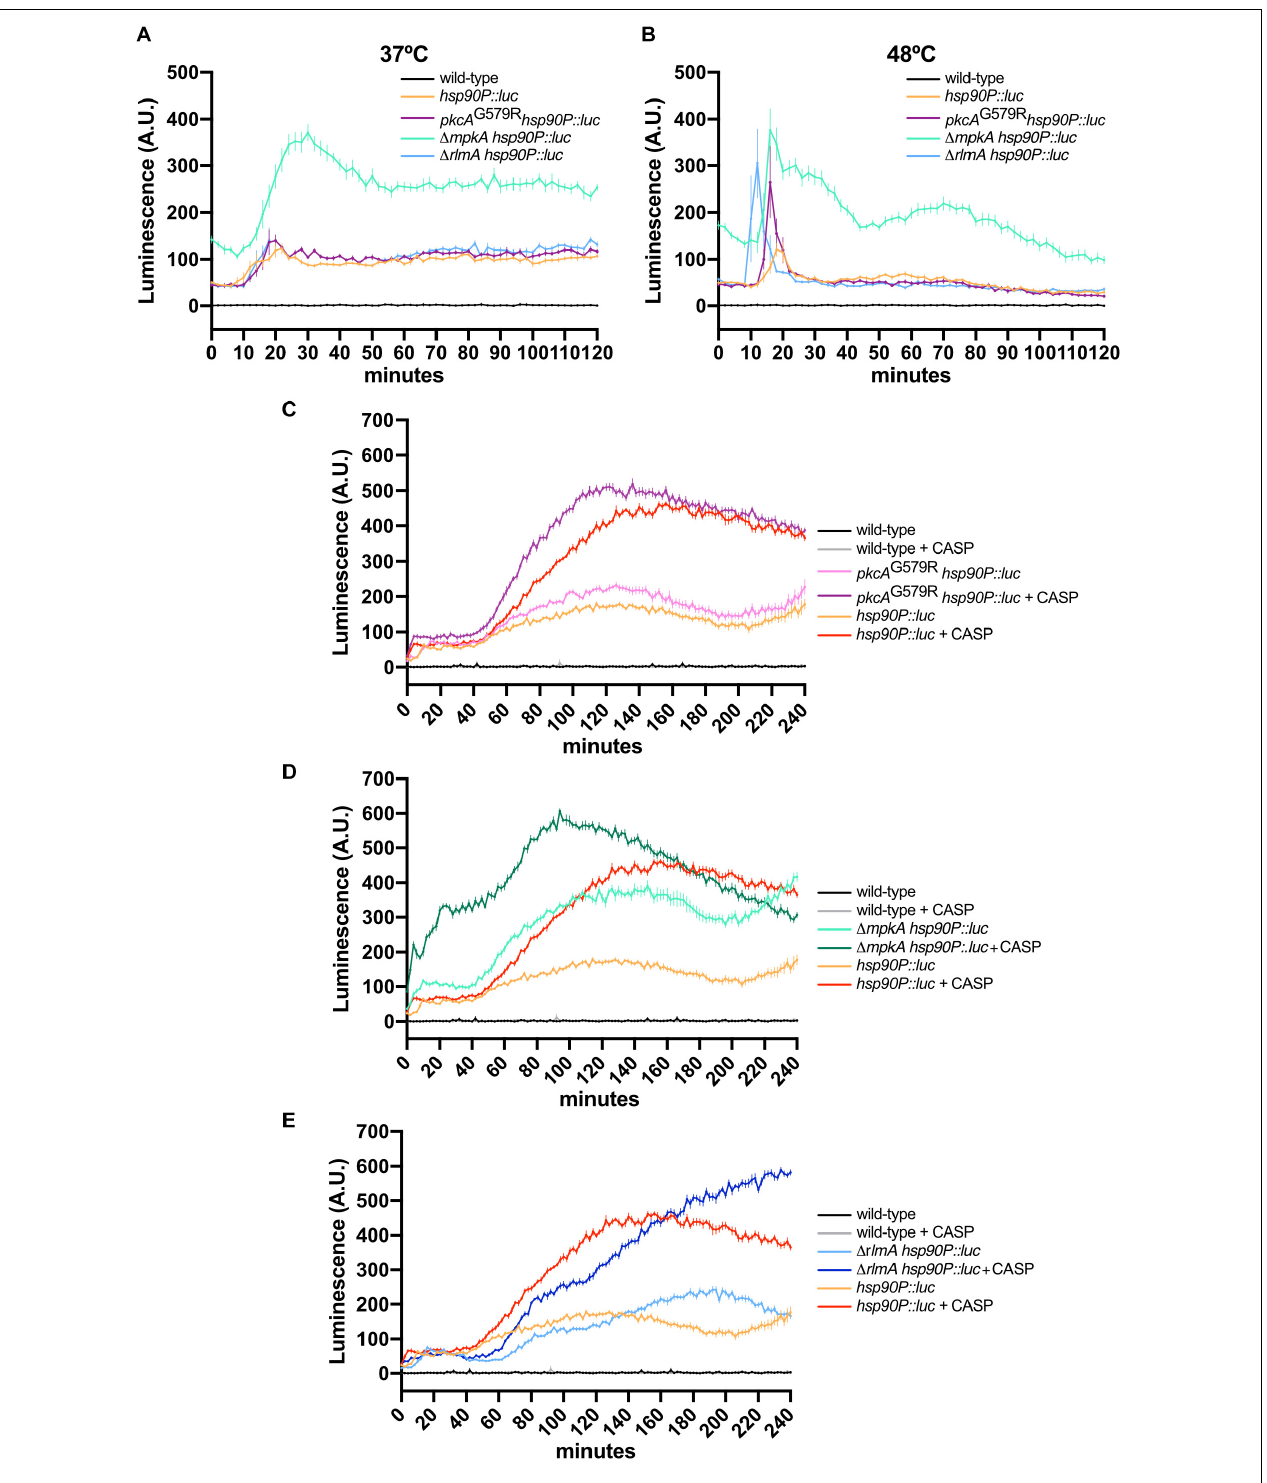
FIGURE 7 | The loss of function of CWI regulators increases hsp90 expression in A. fumigatus biofilms under HS and cell wall stress. (A,B) Luciferase activity assay of the hsp90P::luc , pkcA G 579 R hsp90P::luc , (cid:49) mpkA hsp90P::luc , and (cid:49) rlmA hsp90P::luc strains during the HS at 37 ◦ C (A) and 48 ◦ C (B) . (C–E) Luciferase activity assay of the pkcA G 579 R hsp90P::luc (C) , (cid:49) mpkA hsp90P::luc (D) , and (cid:49) rlmA hsp90P::luc (E) strains during cell wall stress caused by CASP. The wild-type strain without luciferase gene was used as the negative control in all experiments. Mean ± SEM ( n ≥ 8) are shown. The results were normalized by the number of conidia (2 × 10 5 per assay) and are expressed as luminescence (arbitrary units). CASP: caspofungin (2 µ g/ml).